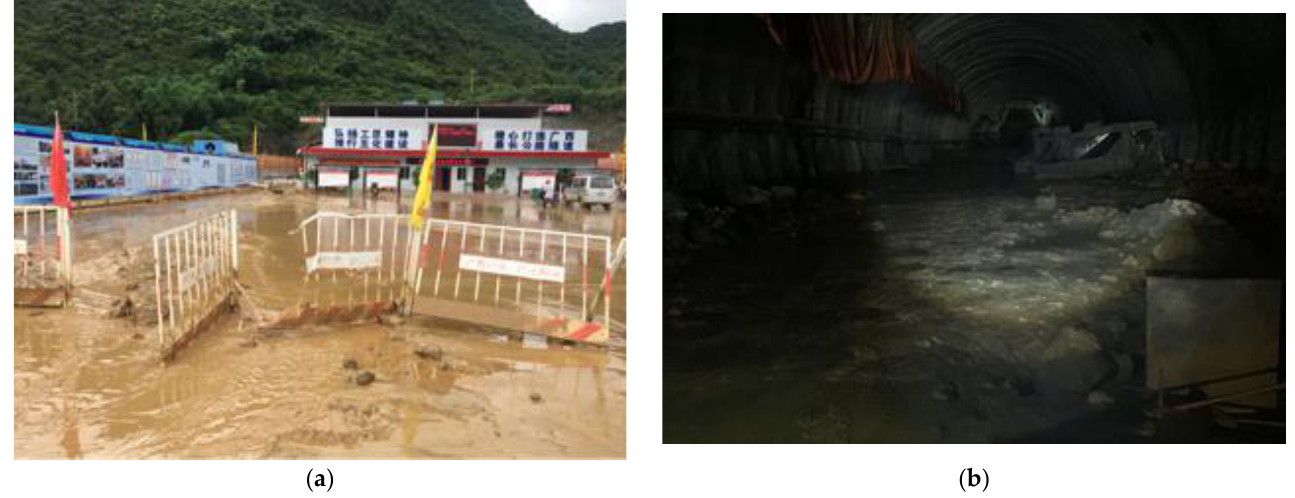
Figure 1. Water gushing and mud outburst in tunnel. ( a ) Facilities at the entrance of cave destroyed by water inrush. ( b ) Water inrush and sludge inside cave.